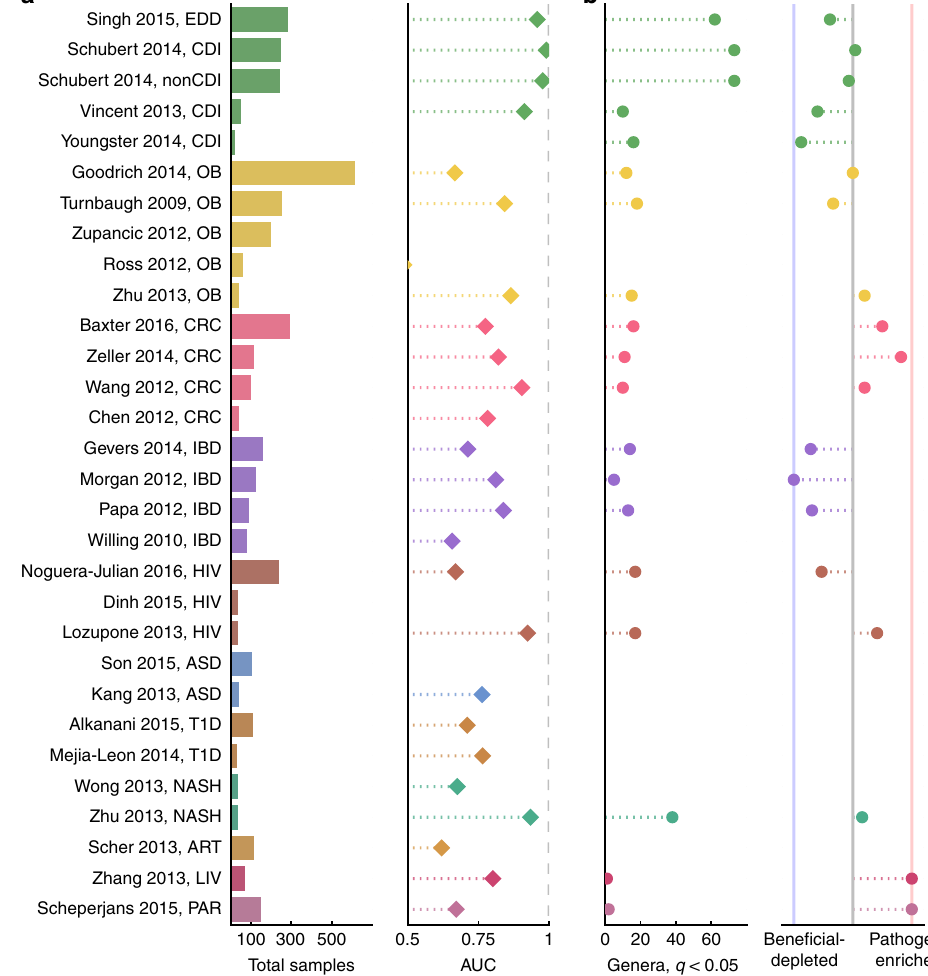
Fig. 1 Most diseases show microbiome alterations, and consistent disease-associated shifts differ in their extent and direction. a Left: Total sample size for each study included in these analyses. Additional information about each data set can be found in Table 1. Studies on the y -axis are grouped by disease and ordered by decreasing sample size (top to bottom). Right: Area under the ROC curve (AUC) for genus-level random forest classi fi ers. X -axis starts at 0.5, the expected value for a classi fi er which assigns labels randomly, and AUCs less than 0.5 are not shown. ROC curves for all data sets are in Supplementary Fig. 1. Note that Youngster et al. 18 had only four distinct control patients was excluded from the random forest analysis. b Left: Number of genera with q < 0.05 (Kruskal – Wallis (KW) test, Benjamini – Hochberg FDR correction) for each data set. If a study has no signi fi cant associations, no point is shown. Right: Direction of the microbiome shift, i.e., the percent of total associated genera which were enriched in diseased patients. In data sets on the leftmost blue line, 100% of associated ( q < 0.05, FDR KW test) genera are health-associated (i.e., depleted in patients relative to controls). In data sets on the rightmost red line, 100% of associated ( q < 0.05, FDR KW test) genera are disease-associated (i.e., enriched in patients relative to controls). Supplementary Figs. 14 and 15 show q values and effects for each genus in each